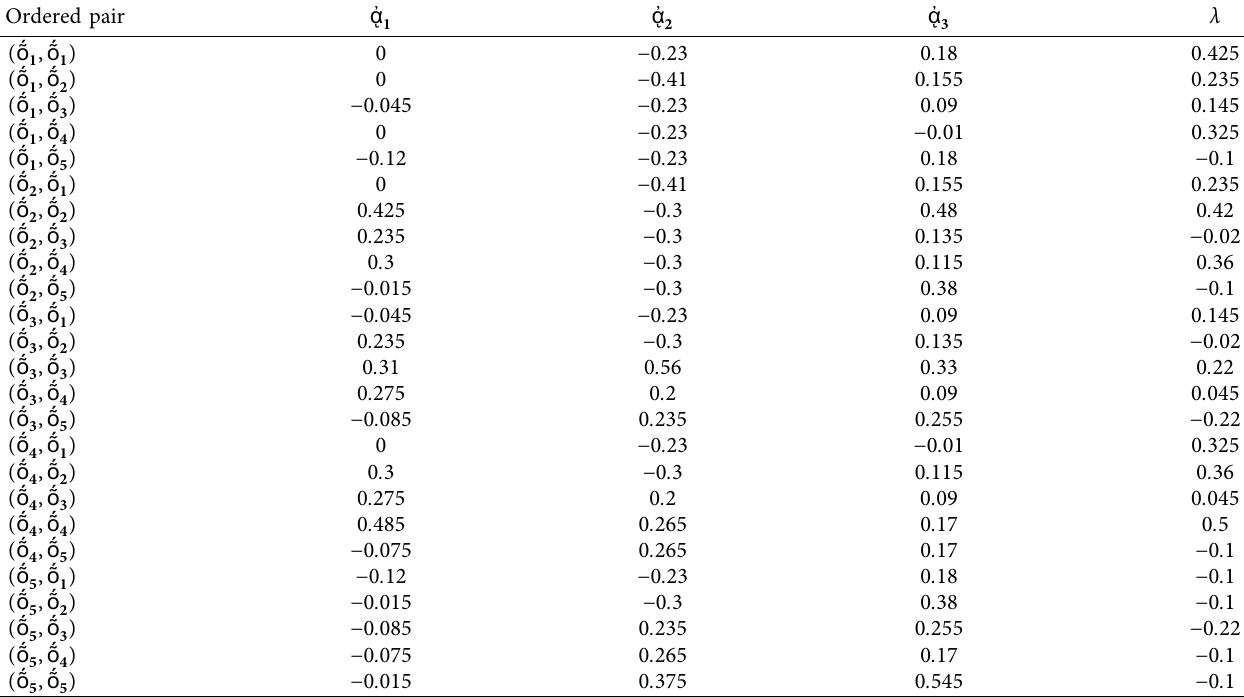
Table 3: Modulus of each complex number.